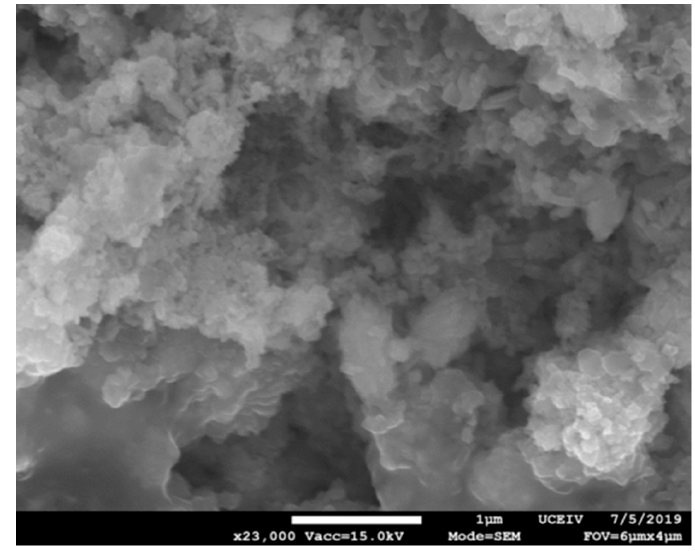
Figure 3. SEM image of Cu 6 Al 1.2 Ce 0.8 -O samples.